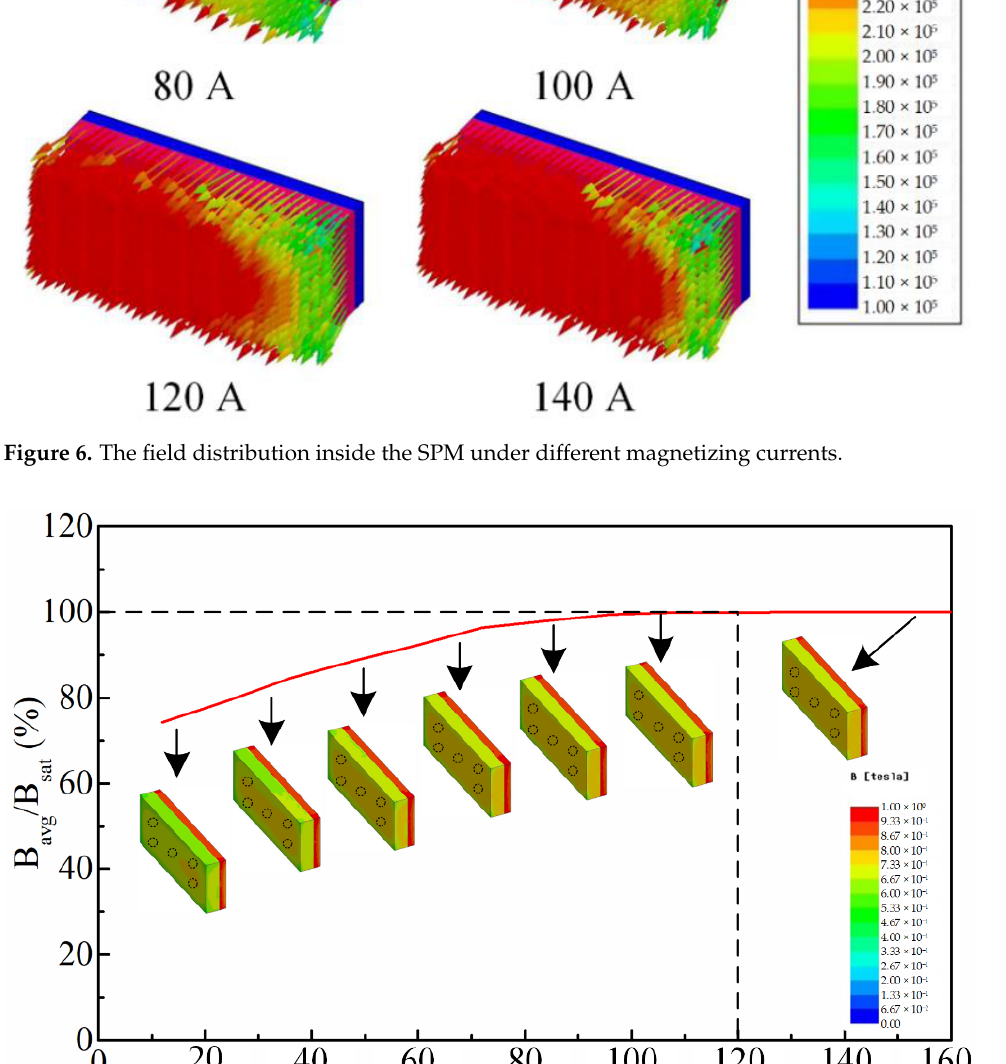
Figure 7. Average resultant magnetic flux density (normalized) on the sample points of the LCF PM after different magnetizing currents.